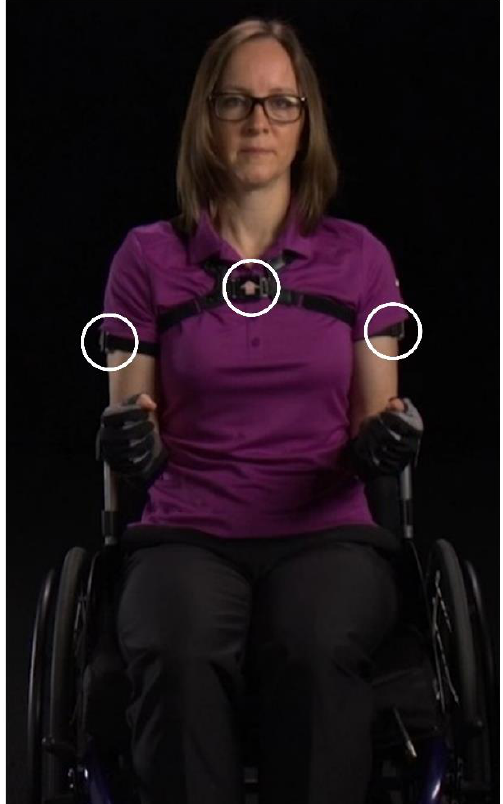
Figure 2. Three inertial measurement units (IMU) were secured to all participants on both of their lateral arms and their chest using elastic straps. The circles indicate where the IMUs are attached. Note: The individual pictured is study staff and not a research